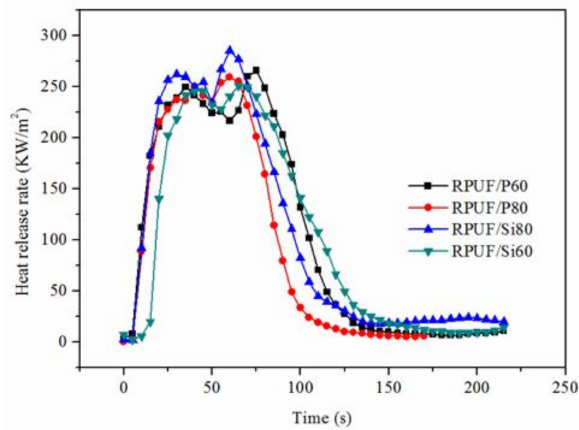
Figure 11. Total heat released (THR) curves of RPUF.